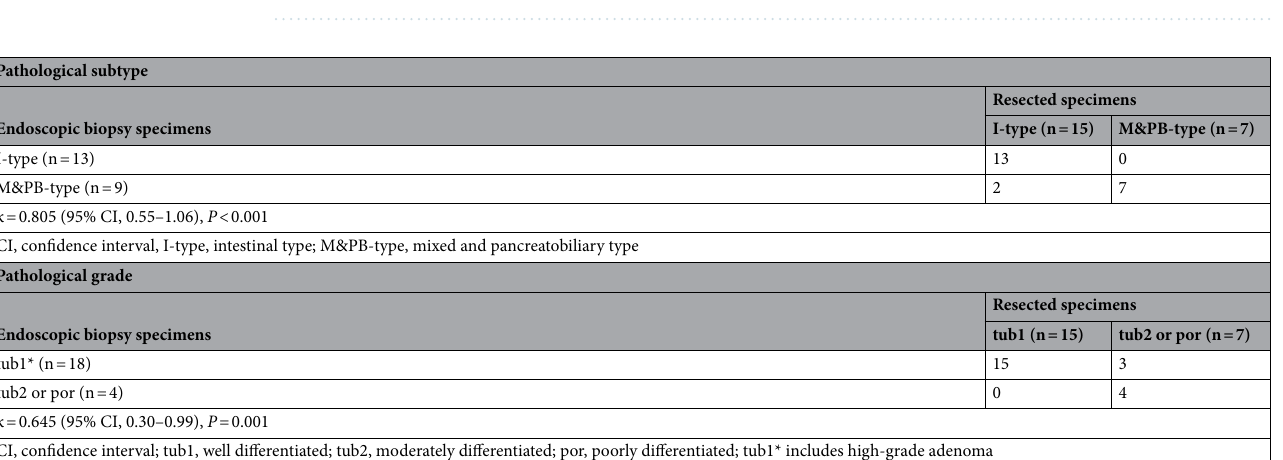
Figure 2. Pathological tumor characteristics of tumors with lymphatic, vascular, or perineural invasion and lymph node metastasis. ( a ) Lymphatic invasion. ( b ) Vascular invasion. ( c ) Perineural invasion. ( d ) Lymph node metastasis. In a–d, the number of intestinal-type Tis/T1a(A), T1a(O), and ≥ T1b lesions were 36, 8, and 13, respectively.